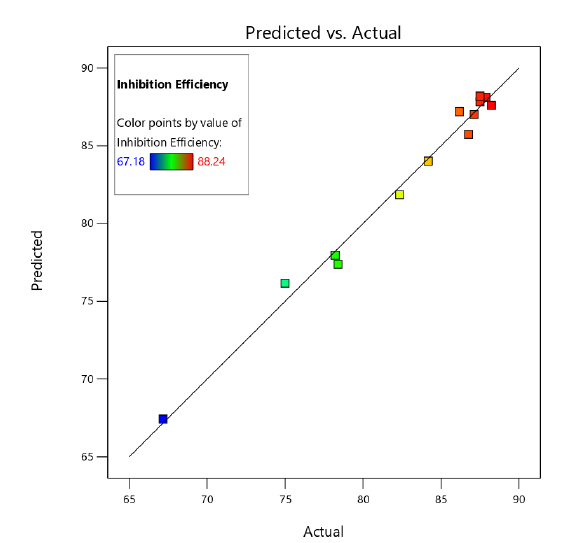
Fig. 5. The correlation between the actual and predicted values via response variable.